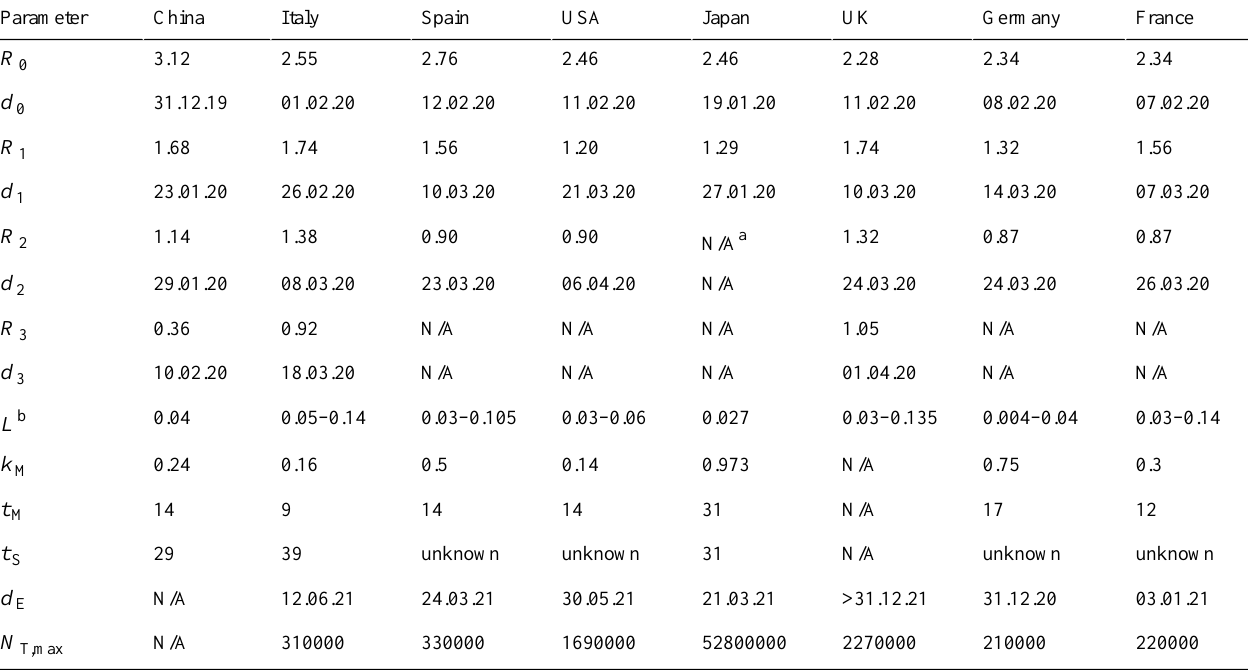
Table 1. Parameters identified from the models used in different